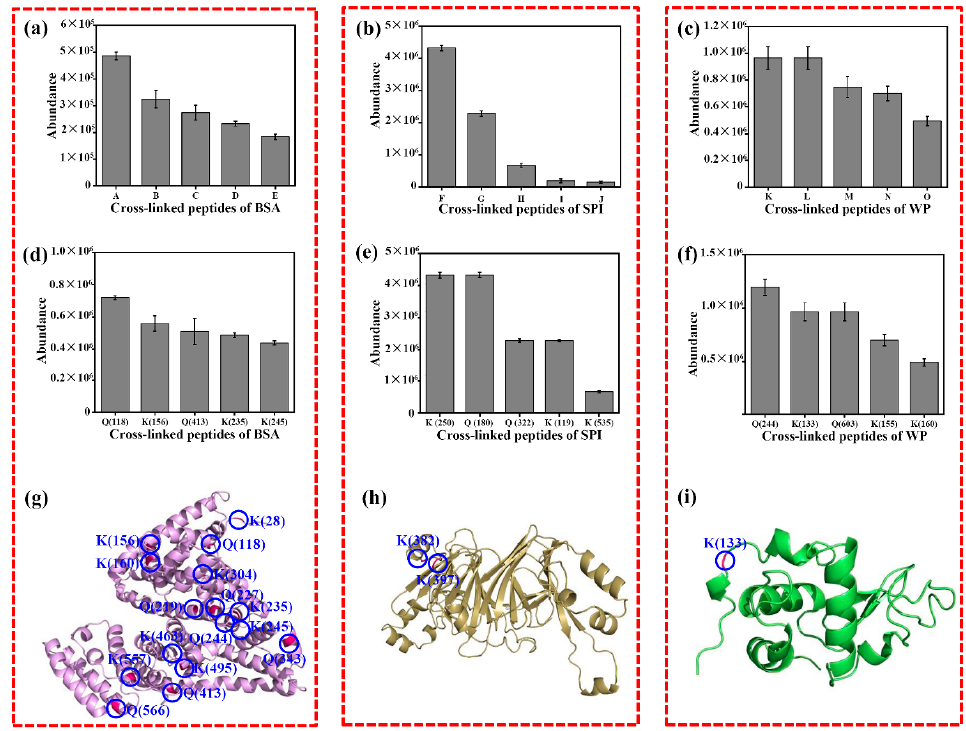
Figure 7. The crosslinking sites in the crosslinked BSA, SPI, and WP were analyzed by BCTG. ( a ) Five of the most plentiful peptides crosslinked in BSA were A (QEPER-FGERALKAWSVAR), B (ADEKKFWGK-QNCDQFEK), C (LSQKFPK-ATEEQLK), D (QEPER-ADEKKFWGK), and E (QNCDQFEK-TPVSEKVTK). ( b ) The five most plentiful peptides crosslinked in SPI were F